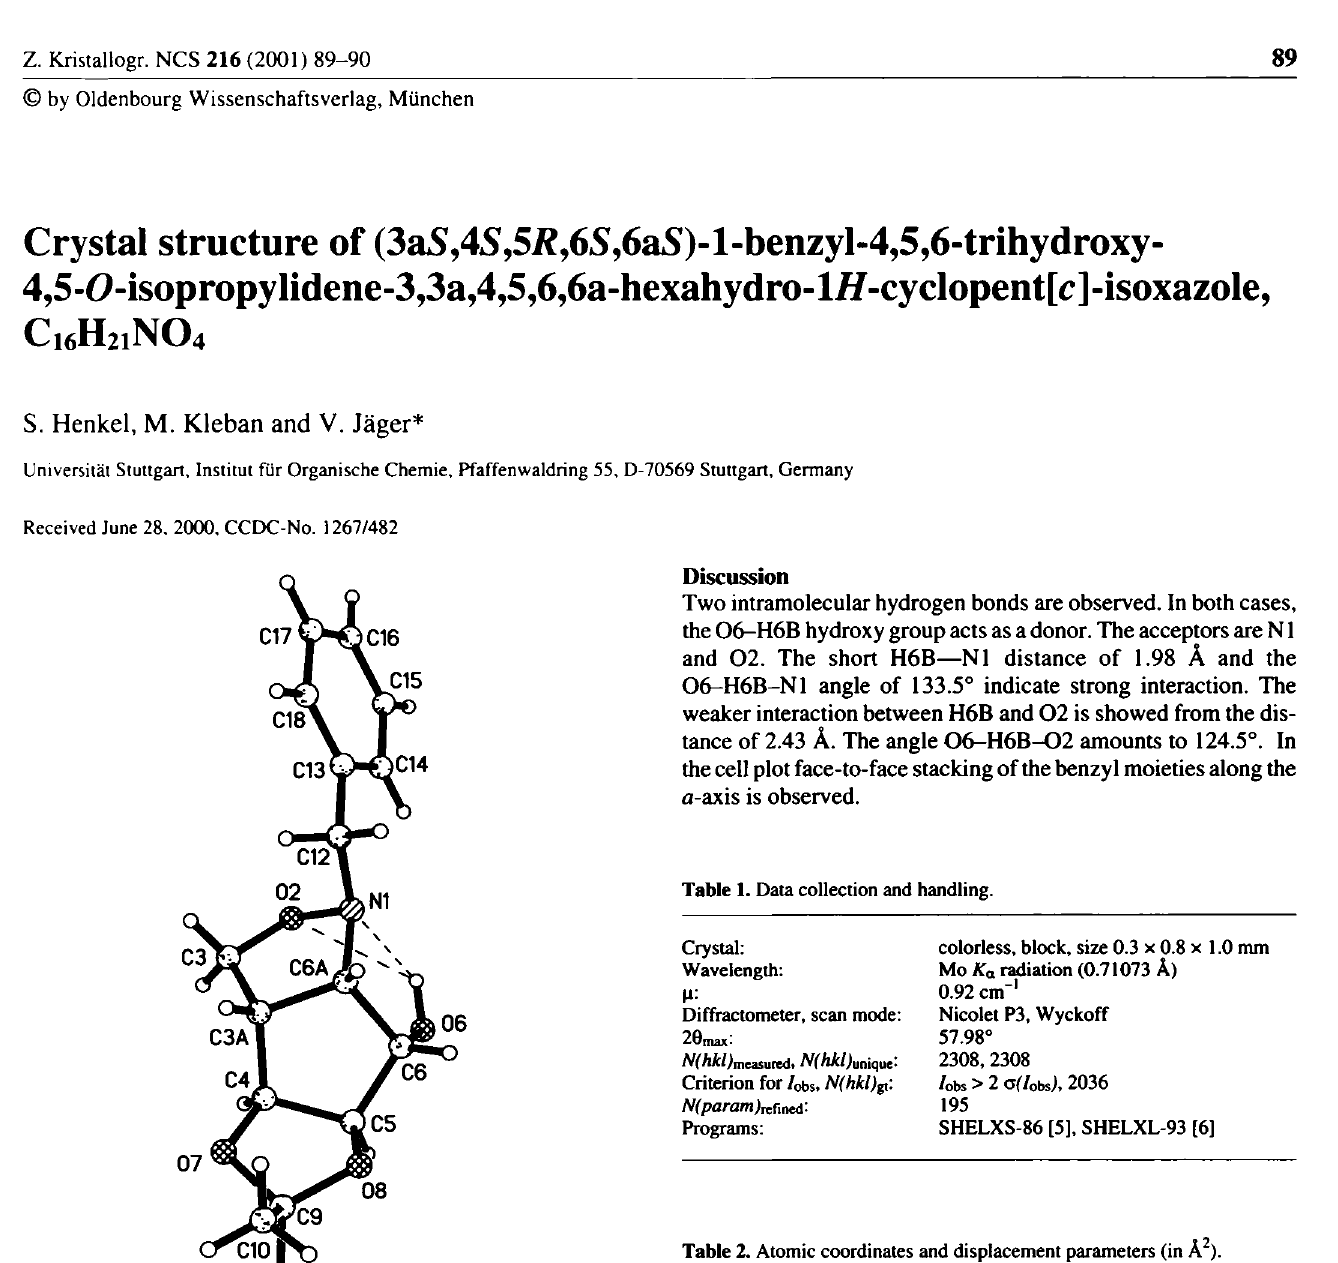
Table 2. Atomic coordinates and displacement parameters (in A 2